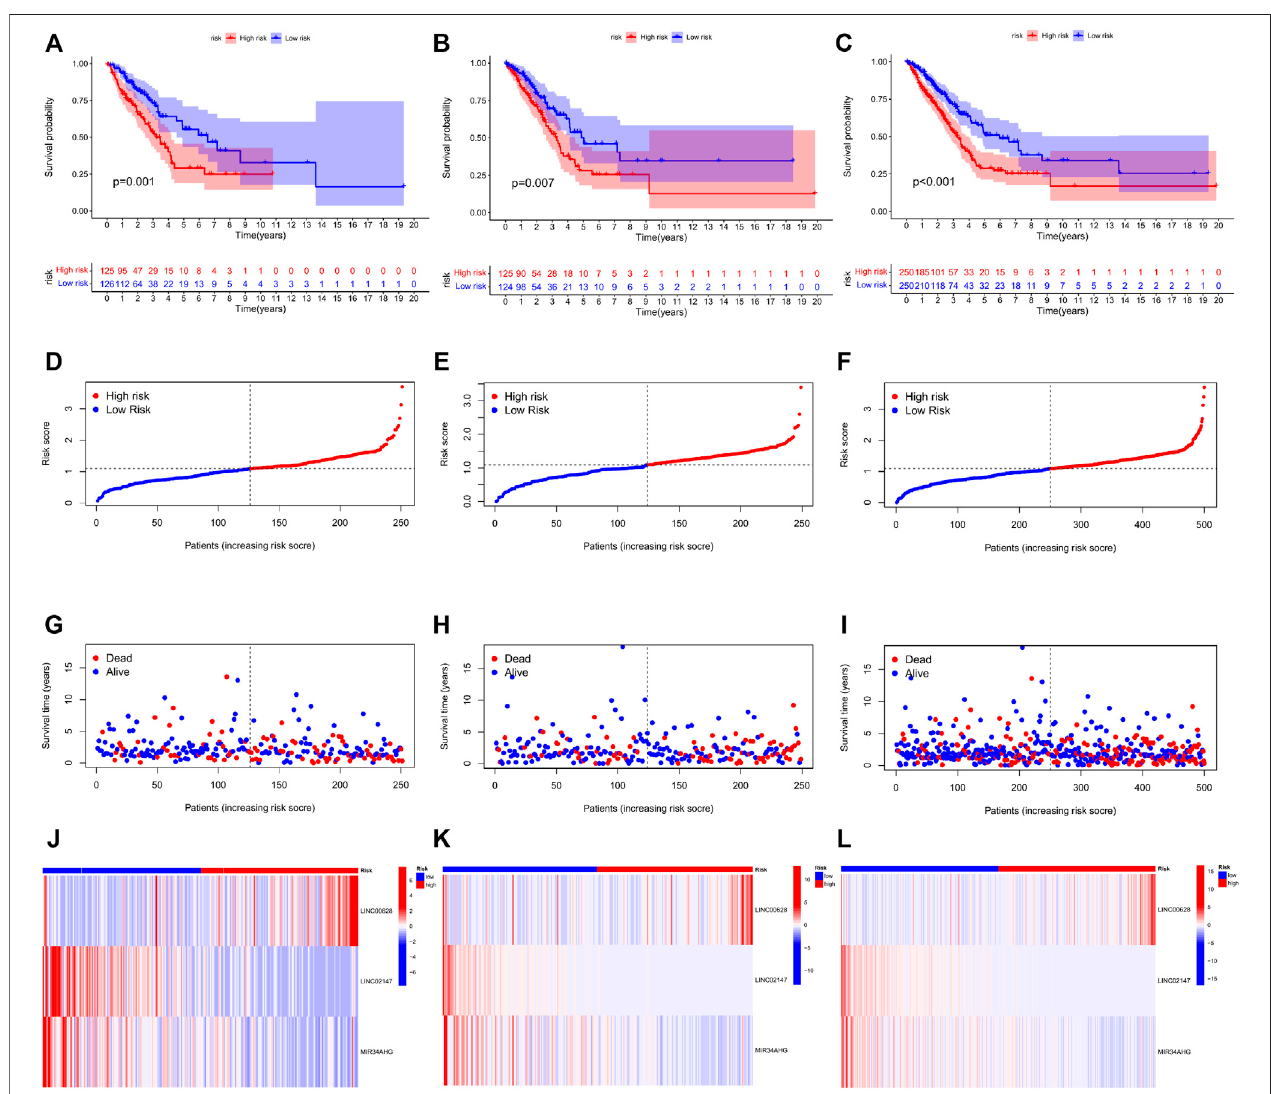
FIGURE 4 | Risk score distribution and survival status in the training, validation and total TCGA-LUAD sets. The survival status, risk score, gene expression level in the risk score and follow-up time of each sample are shown.